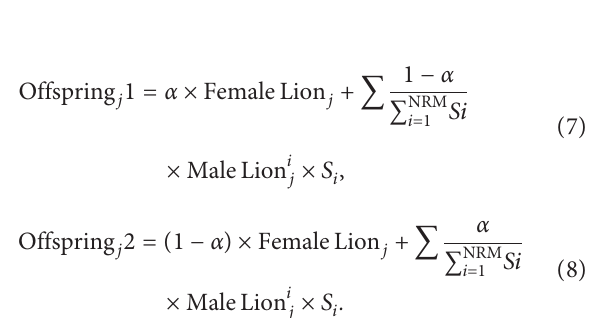
Figure 3: Structure of LSTM gates.